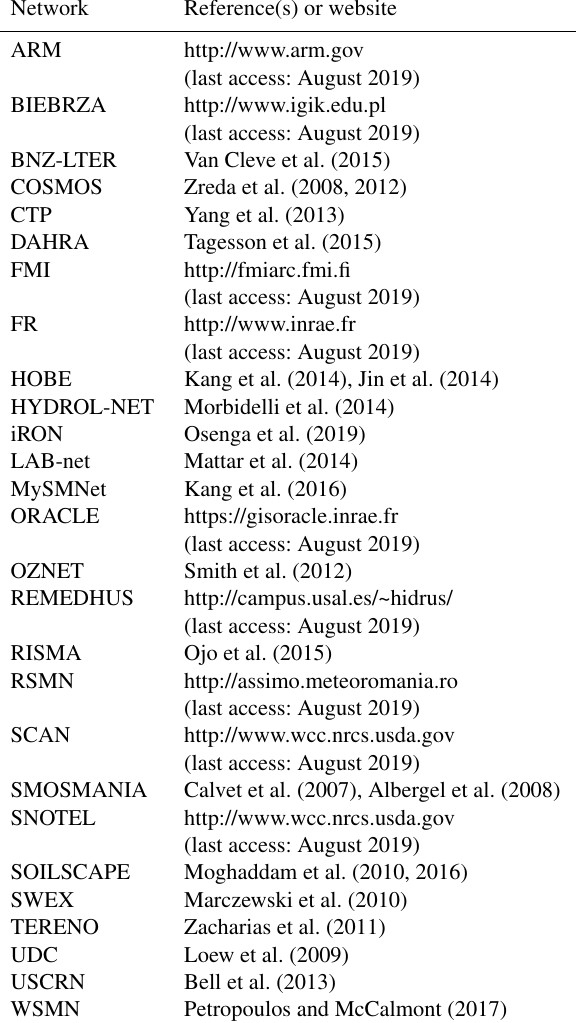
Table A1. The measurement networks from which we have used in situ soil moisture